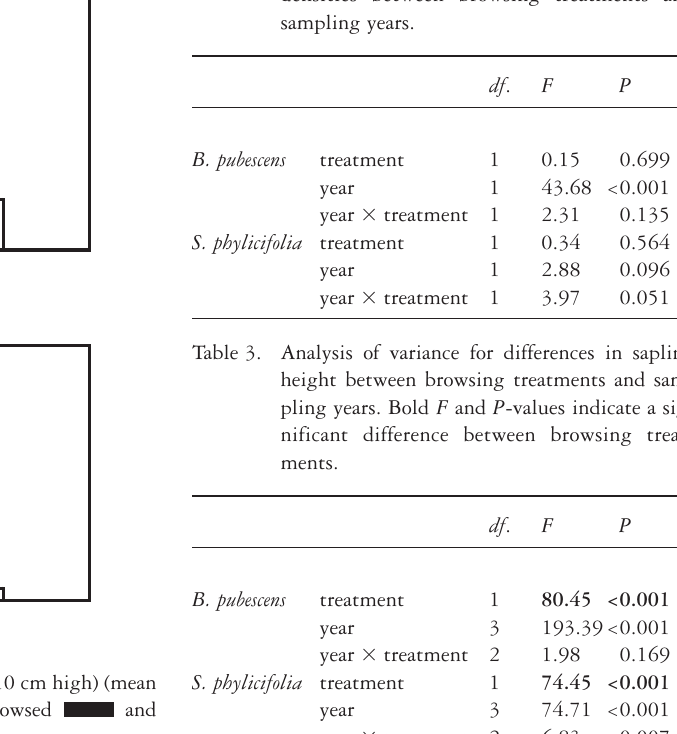
Fig. 4. Seedlings densities (plants < 10 cm high) (mean number per m2 + SE) in browsed and unbrowsed plots.